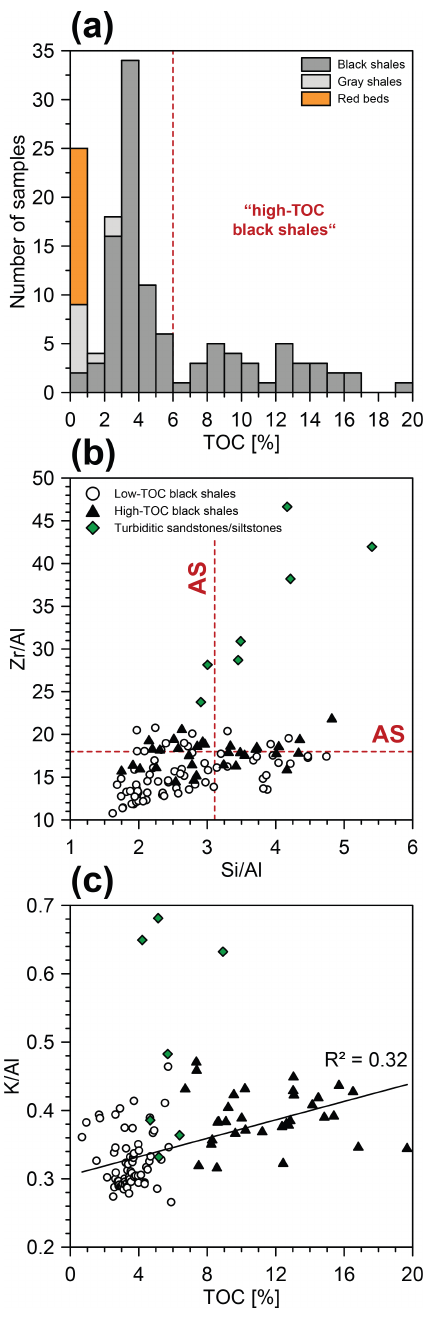
Figure 3. Geochemical characteristics of the different lithostrati- graphic (sub)units: (a) histogram showing the TOC contents of sam- ples from different lithostratigraphic units (i.e., black shales, gray shales, and red beds). Panel (b) shows cross-plots of XRF-derived grain size proxies Si / Al and Zr / Al for black shale samples, which are grouped into high-TOC black shales (TOC > 6%) and low- TOC black shales (TOC < 6%). Green diamonds represent samples taken from intercalated sandstones, which are plotted for reference. Panel (c) shows cross-plots of TOC content and K / Al ratios. AS stands for average